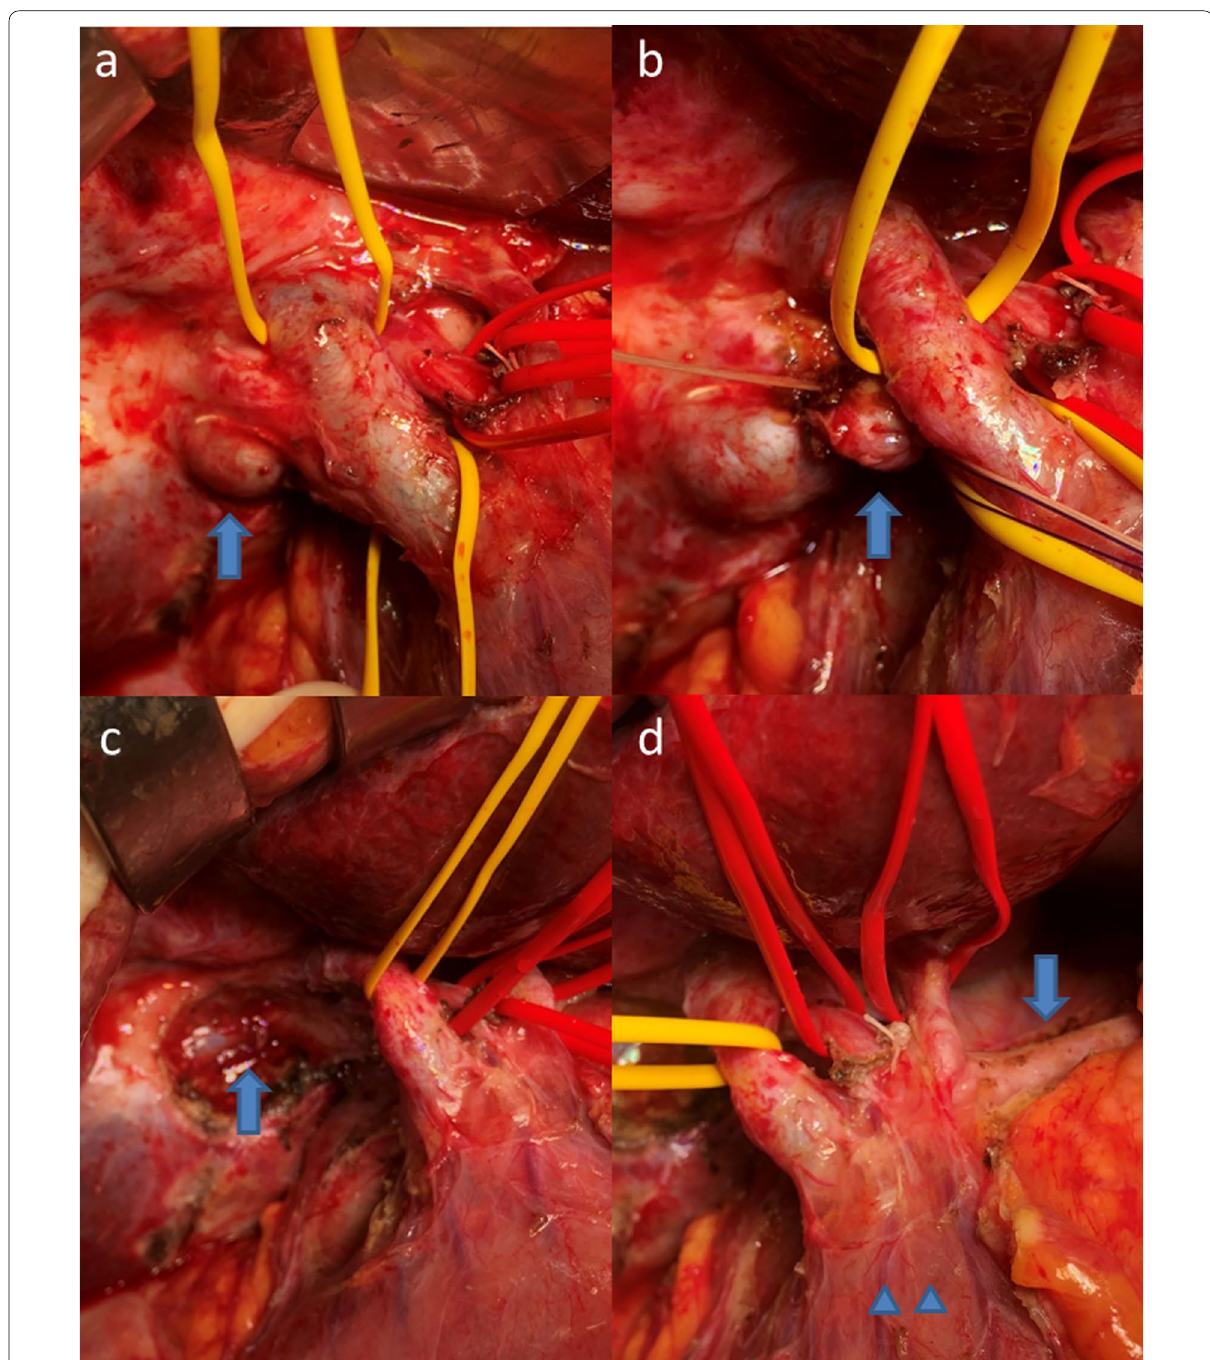
Fig. 4 Intraoperative findings. a A soft mass without evidence of extramural invasion was palpable at the remnant gallbladder (arrow). During lymph node dissection around the hepatic portal region, hepatic and duodenal side bile duct where the cystic duct diverged was taped (yellow tapes). b Using these tapes, approximately 20 mm of the cystic duct located behind the bile duct could be safely exposed. The cystic duct was ligated (arrow) and cut, and the cystic ductal margin was negative on frozen section. c Remnant cholecystectomy with remnant gallbladder bed resection was performed. The right branch of the portal vein was exposed (arrow). d Postoperative status after remnant cholecystectomy, remnant gallbladder bed resection, and regional lymph node dissection. The arrow indicates the common hepatic artery. The right and left hepatic arteries were taped (red tapes). The upper duodenal arteries and the right gastric artery were preserved